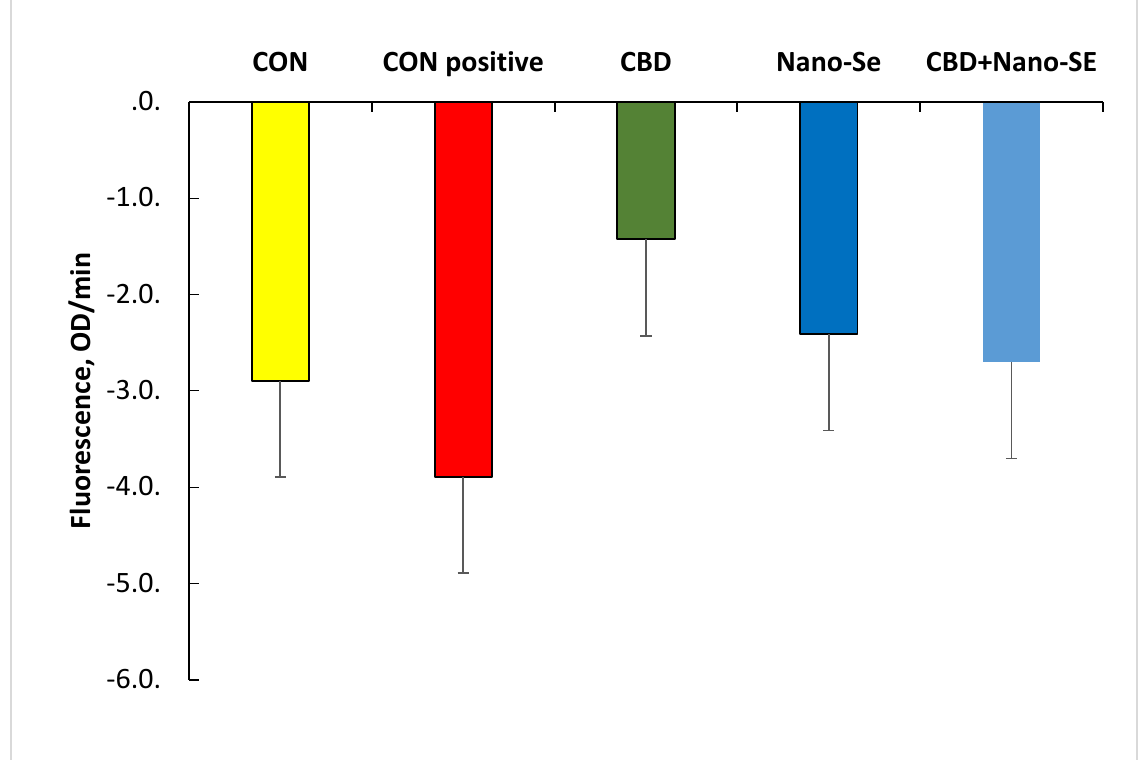
Figure 2. Oxygen consumption rate in platelet mitochondria expressed as the rate of fluorescence signal change per minute. CON—untreated control group; CON positive—birds fed a CON diet and challenged with Clostridium perfringens on days 15, 16, 17 and 18 of age; CBD—CON positive + dietary supplementation with cannabidiol; Nano-Se—CON positive + dietary supplementation with nano form of selenium; CBD + Nano-Se—CON positive + dietary supplementation with both additives. Error bars represent the mean standard errors for 8 birds in each dietary treatment (SEM = 0.318 and p = 0.250).